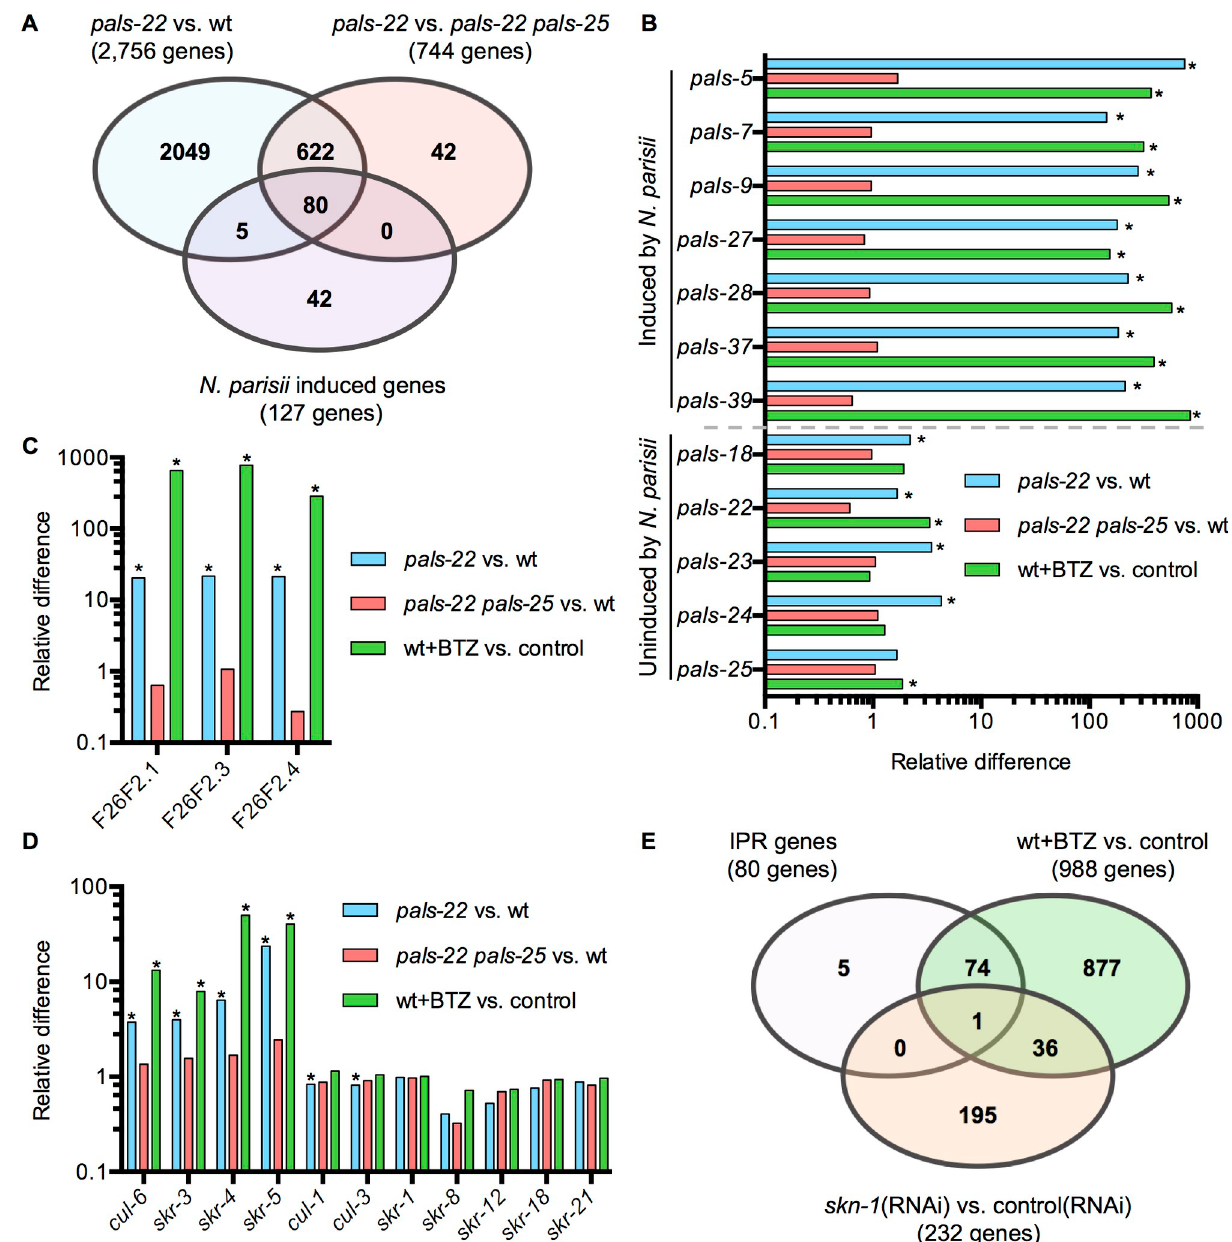
Fig 6. The pals-22/25 gene pair transcriptionally regulates genes that are induced by N . parisii infection or proteasome blockade. (A) Venn diagram comparing 1) genes upregulated in pals-22 mutants compared to wild-type animals, 2) genes upregulated in pals-22 mutants compared to pals-22 pals-25 double mutants and 3) genes induced in wild-type animals in response to N . parisii infection. Gene sets 1 and 2 were obtained from RNA-seq data outlined in this study, and Gene set 3 was obtained via RNA-seq in a previous study [9]. Gene sets 1 and 2 have a highly significant overlap (rf = 3.9; p < 1.0E-317), gene sets 1 and 3 significantly overlap (rf = 2.8; p < 1.41E-24), as do gene sets 2 and 3 (rf = 9.6; p < 2.48E-63). We define the IPR genes as the 80 genes common across the three gene sets. (B-D) The relative mRNA levels measured by RNA-seq in: pals-22(jy3) animals compared to wild-type; pals-22(jy3) pals-25(jy9) animals compared to wild-type; and wild-type animals treated with the proteasome inhibitor bortezomib (BTZ) compared to DMSO (vehicle control for BTZ). � FDR < 0.01 as calculated by edgeR and limma (see Materials and Methods) indicates the gene is considered to be differentially expressed. (B) pals genes induced by N . parisii infection are also regulated by pals-22/25 and induced by BTZ. (C) Species-specific F26F2 genes are regulated by the pals-22/25 gene pair and are induced by BTZ. (D) The Cullin-Ring Ligase components Cullin ( cul) and Skp-related ( skr) genes that are upregulated during N . parisii infection are also regulated by the pals-22/25 gene pair and induced by BTZ. (E) Venn Diagram showing overlap between: IPR genes defined in (A); genes upregulated due to treatment with BTZ; and genes upregulated by skn-1 [21]. The overlap between IPR genes and genes induced following BTZ treatment is highly significant (rf = 10.8; p < 2.68E-74), while the overlap between IPR genes and SKN-1 regulated genes is that expected by random chance (rf = 0.6; p < 0.487). The overlap between BTZ-induced genes and SKN-1 regulated genes is considered significant (rf = 1.8; p < 2.04E-4). See S2 and S3 Tables for detailed expression levels of genes discussed here. https://doi.org/10.1371/journal.ppat.1007528.g006 PLOS Pathogens| https://doi.org/10.1371/journal.ppat.1007528 January14, 2019 14 /